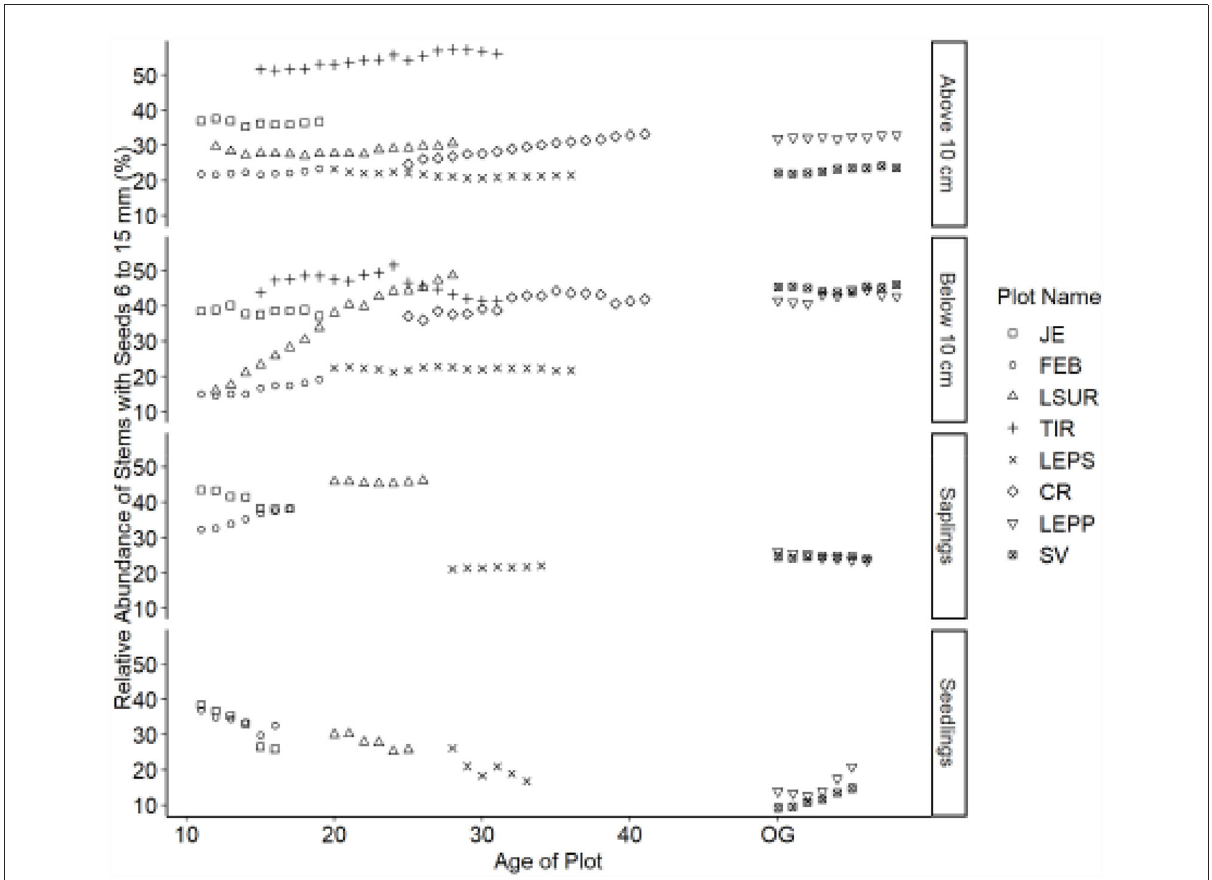
TABLE 4 Linear mixed models for large seeds (Size) and zoochory (Zoo) for seedlings, saplings, trees 5 ≤ y < 10cm dbh, and trees y ≥ 10cm dbh in second-growth plots. Form Model